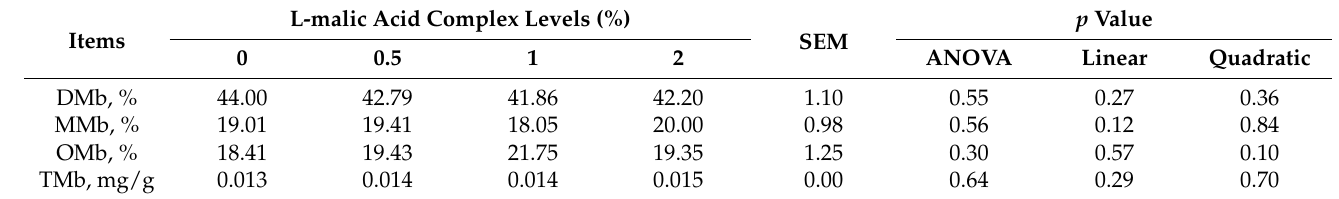
Table 6. Effects of dietary supplementation with L-malic acid on the LD muscle myoglobin of finishing pigs ( n = 8).